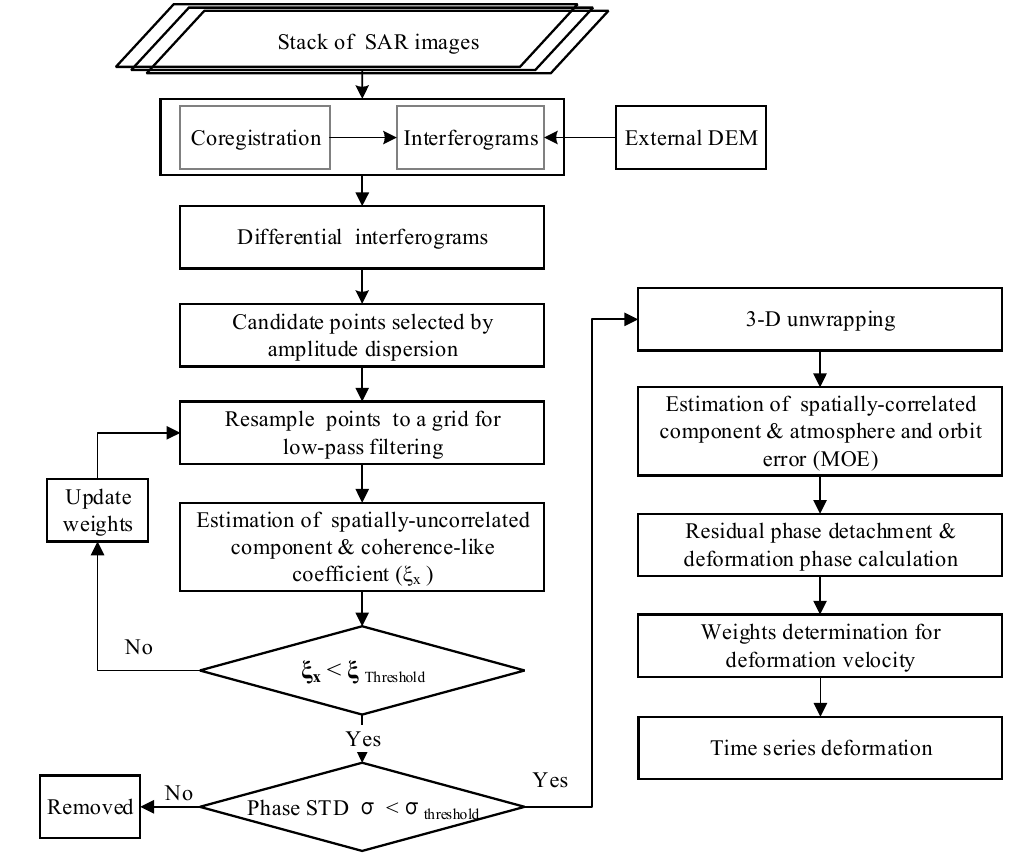
Figure 2. Flow chart of the proposed PSI technique.